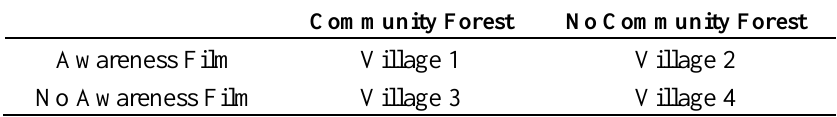
Table 1. Study design incorporating four villages in the central